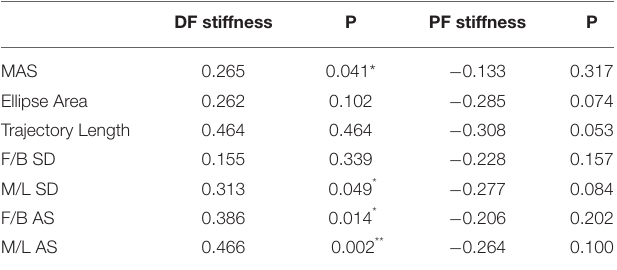
TABLE 5 | Correlations Between stiffness and Pro-Kin balance test results when open eyes.